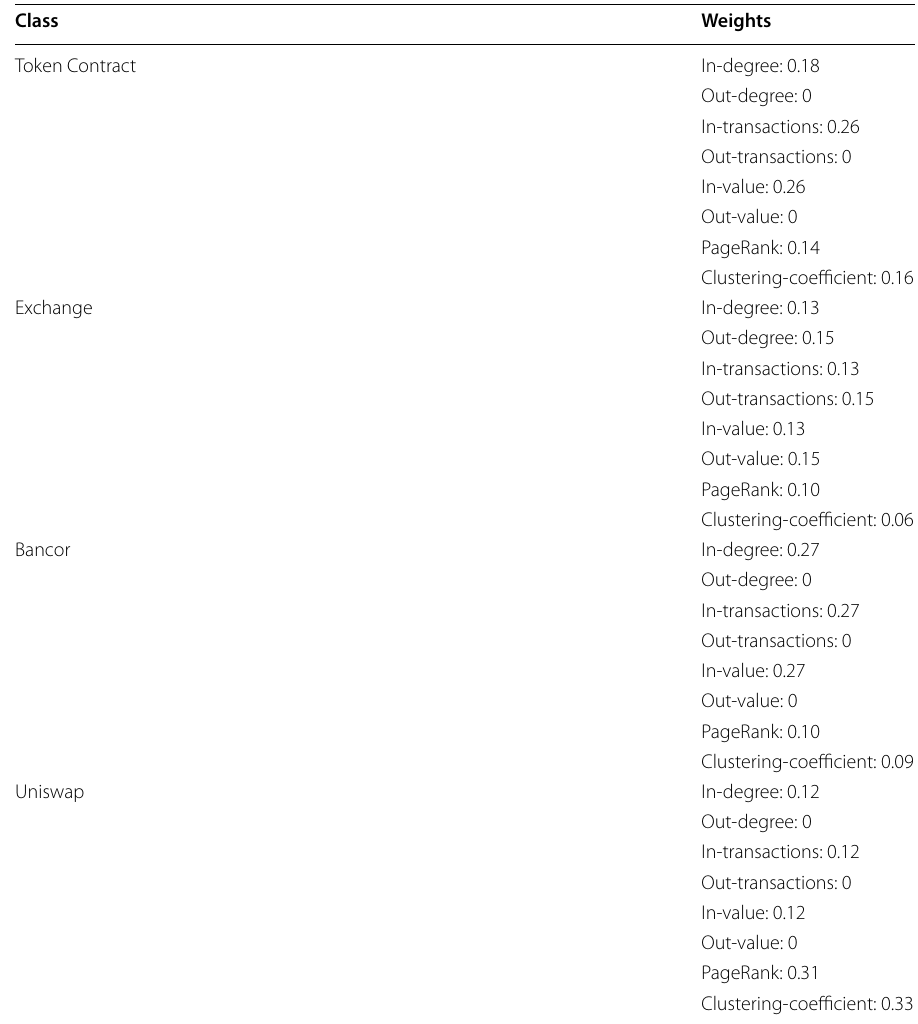
Table 8 Weights combination for the Eros distance relative to each class of interest Class Weights Token